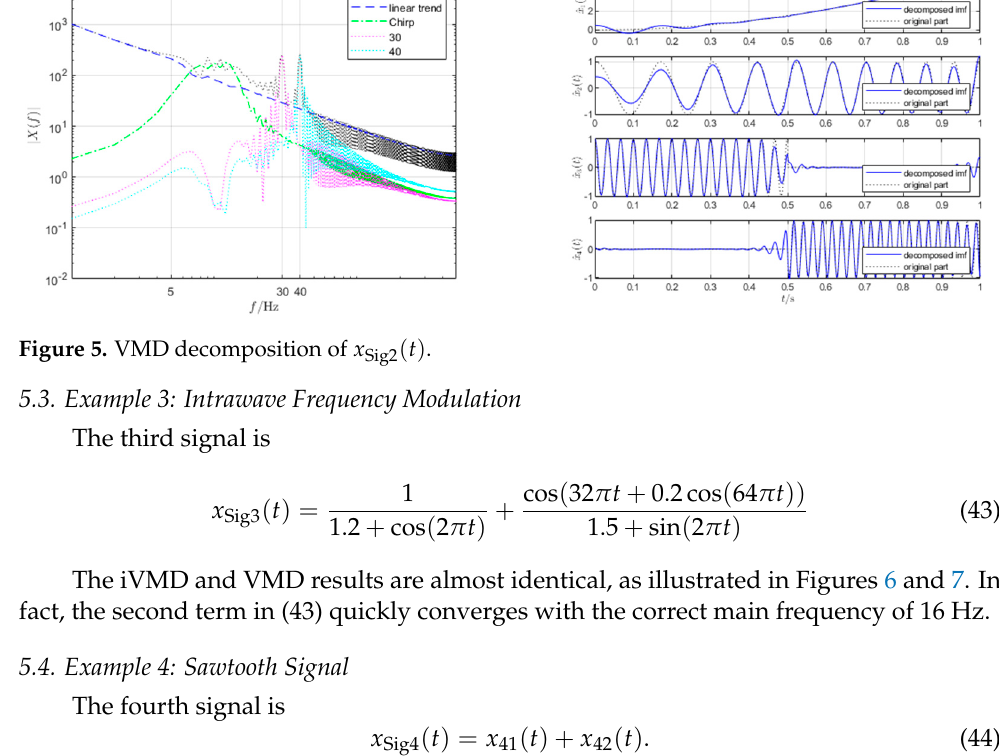
Figure 6. iVMD decomposition of 𝑥 (cid:2903)(cid:2919)(cid:2917)(cid:2871) (𝑡) run via iVMD. The left shows the IMF’s spectra, and the right shows the reconstructed modes. In the reconstructed modes, we show four figures. The left two are the IMFs, and the right two show the differences between the estimated IMF and the original. Figure 7. VMD decomposition of 𝑥 (cid:2903)(cid:2919)(cid:2917)(cid:2871) (𝑡) . 0